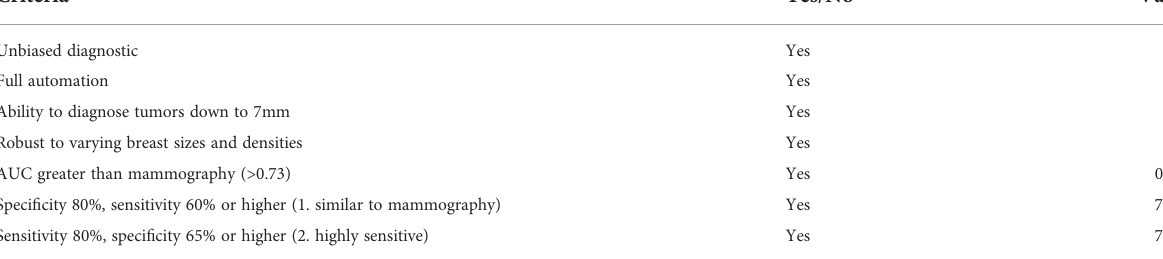
Sensitivity (with 80% speci fi city)